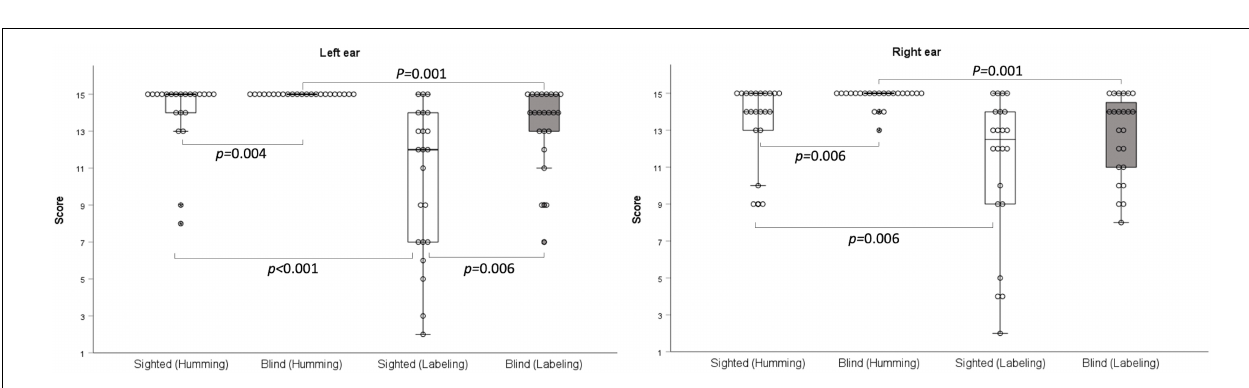
other words, the symmetric performances of both ears